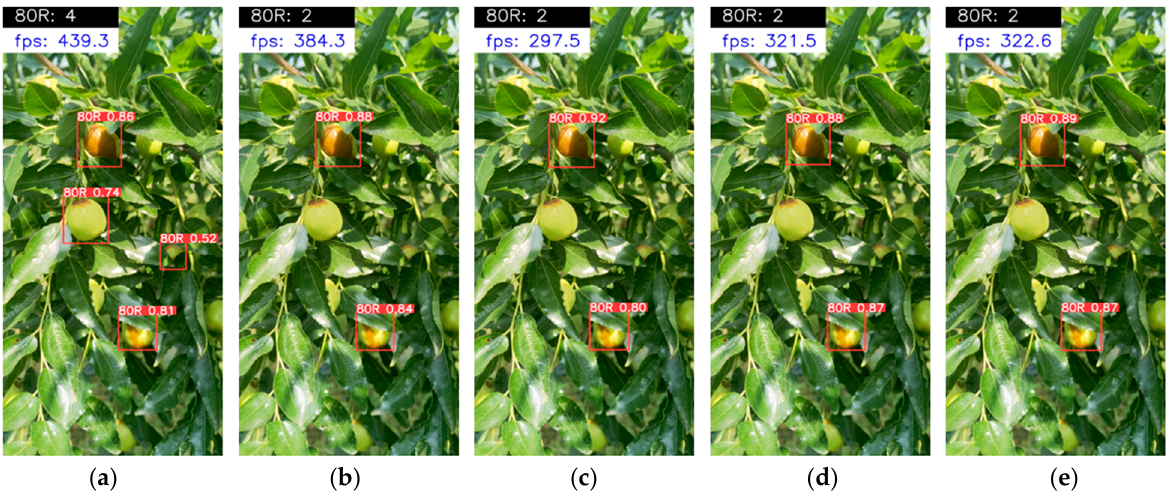
Figure 6. The sorted and counted target of 80R from an image tested on: ( a ) YOLOv3-tiny; ( b ) YOLOv4-tiny; ( c ) YOLOv5s; ( d ) YOLOv7-tiny; ( e ) YOLO-Jujube method.